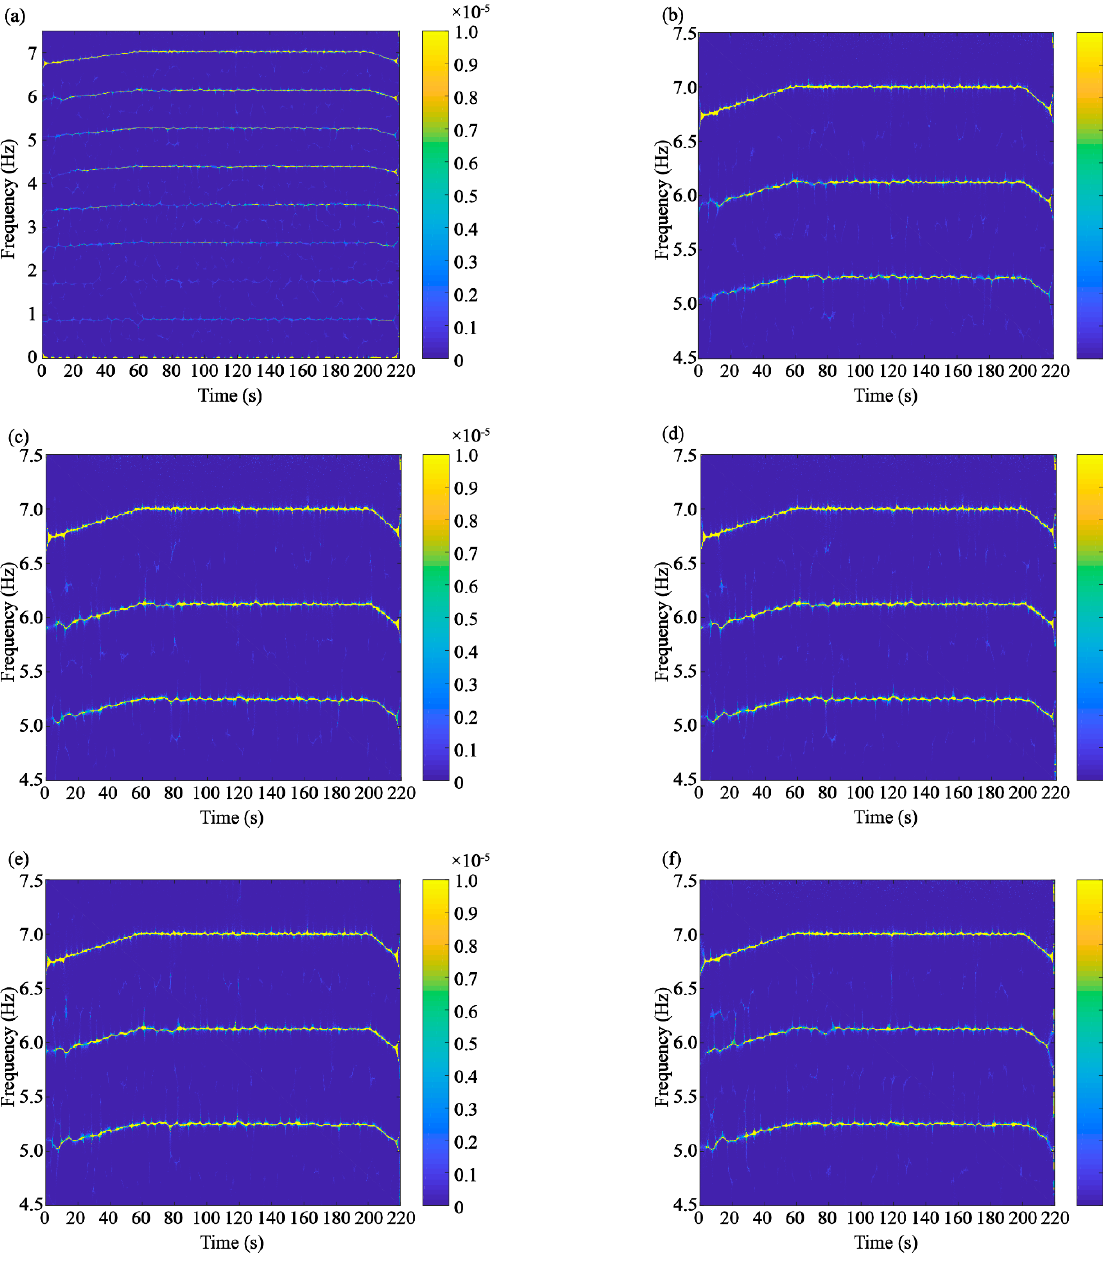
Figure 7. TFR spectrogram of measured acceleration response. ( a ) Sensor 1-global view, ( b ) Sensor 1 ( c ) Sensor 2, ( d ) Sensor 3, ( e ) Sensor 4, ( f ) Sensor 5-zoom-in view.